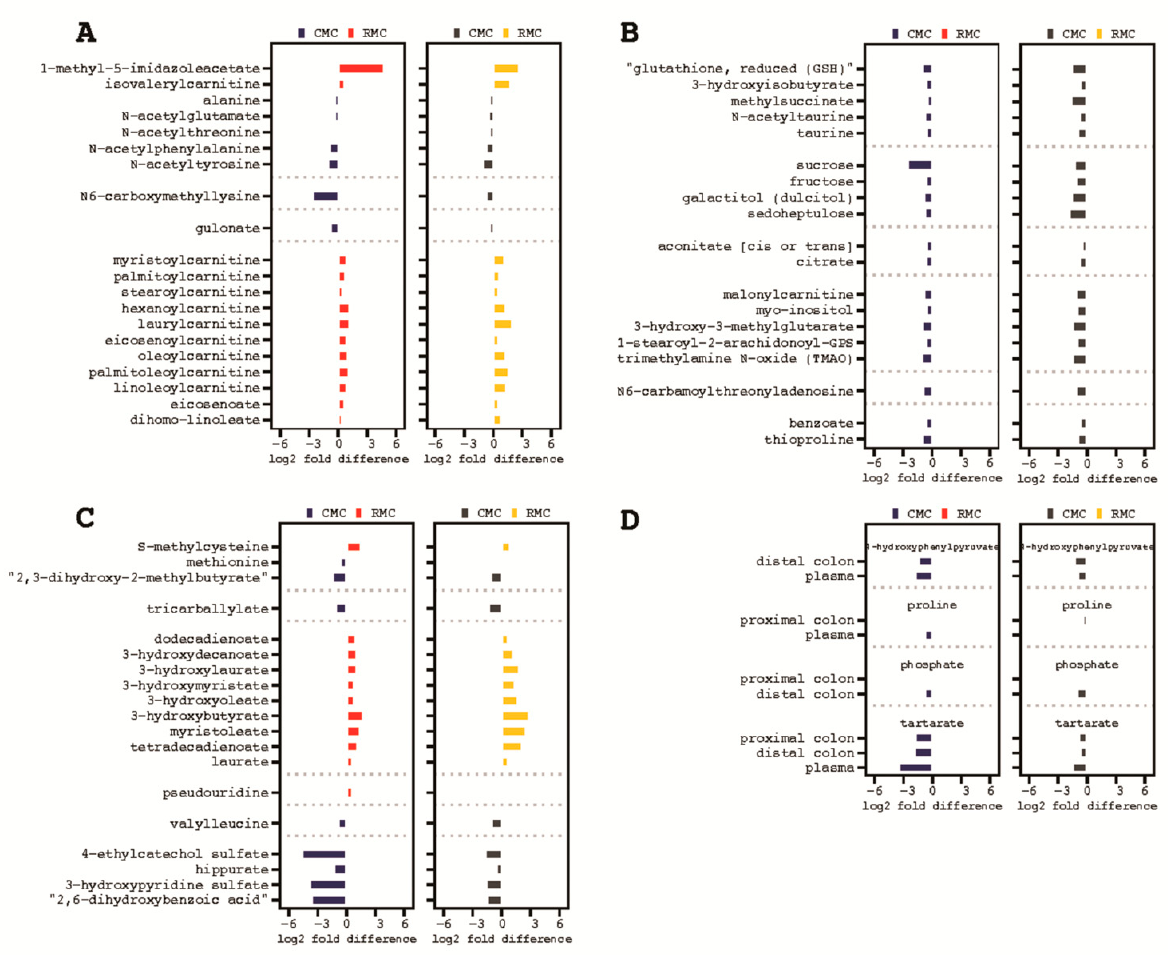
Figure 7. Differentially abundant metabolites in colon and plasma following control fecal microbial transplantation (CMC) and rice bran modified fecal microbial transplantation (RMC). ( A ), proximal colon. ( B ), distal colon. ( C ), plasma. ( D ), conserved metabolites across two or more sample types. Left panel represent the human female donor and right sides within each panel represent mice transfaunated with consortia from the human male